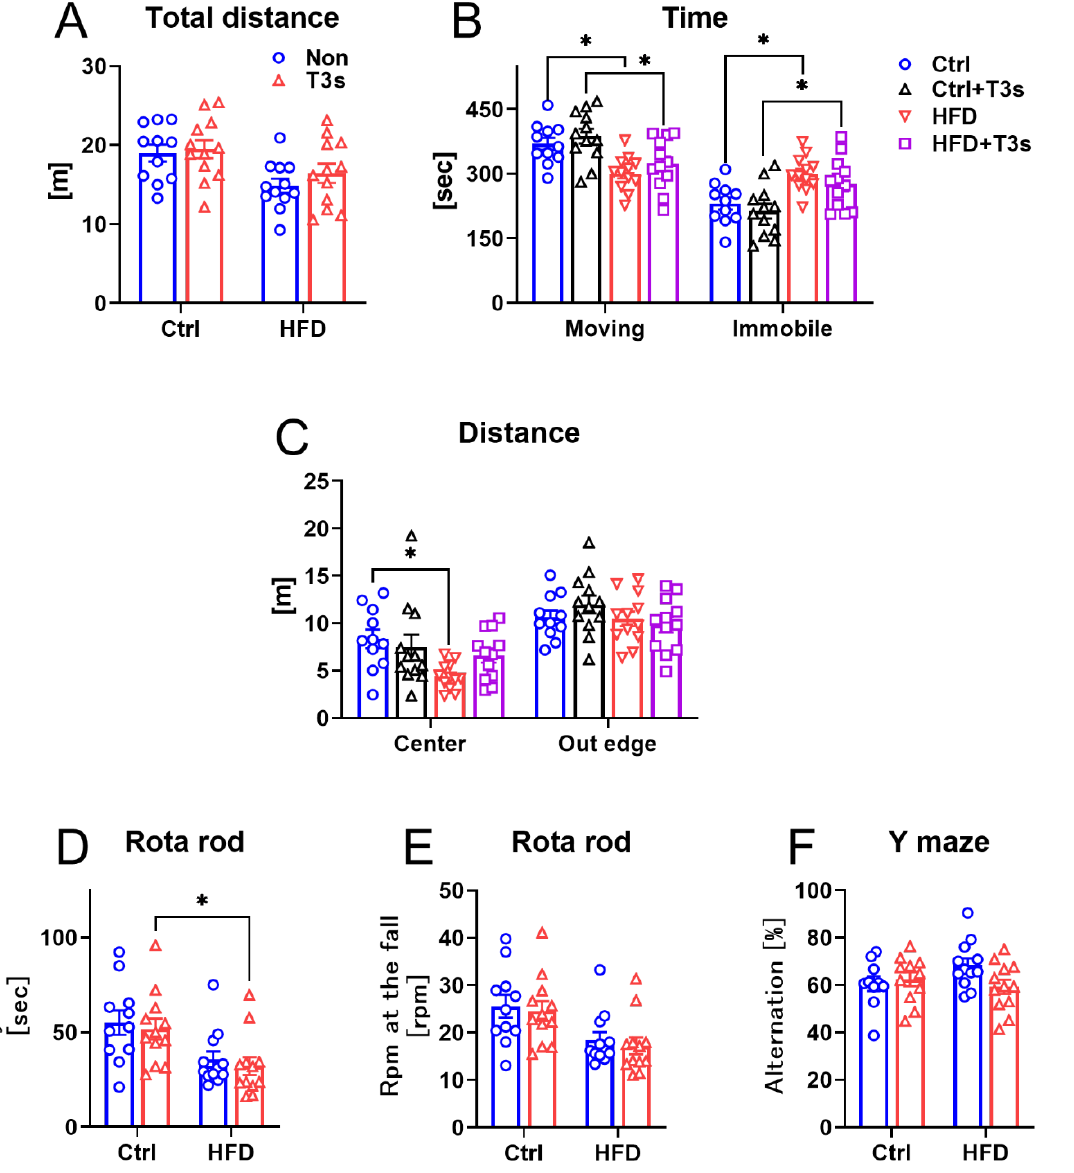
Figure 2. The changes in mice behavior. ( A – C ) Open field test. (Ctrl, n = 11; Ctrl + T3s, HFD and HFD + T3s, n = 12). ( D , E ) Latency to fall and rpm at fall in the rota rod test. (Ctrl, n = 11; Ctrl + T3s, HFD and HFD + T3s, n = 12). ( F ) Alternation score by Y-maze test. (Ctrl, n = 11; Ctrl + T3s, HFD and HFD + T3s, n = 12). * p < 0.05, two-way ANOVA with the Tukey–Kramer method.